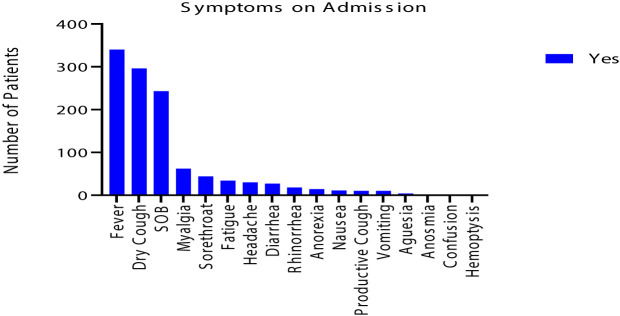
The distribution of the 525 symptomatic COVID-19 patients on admission.